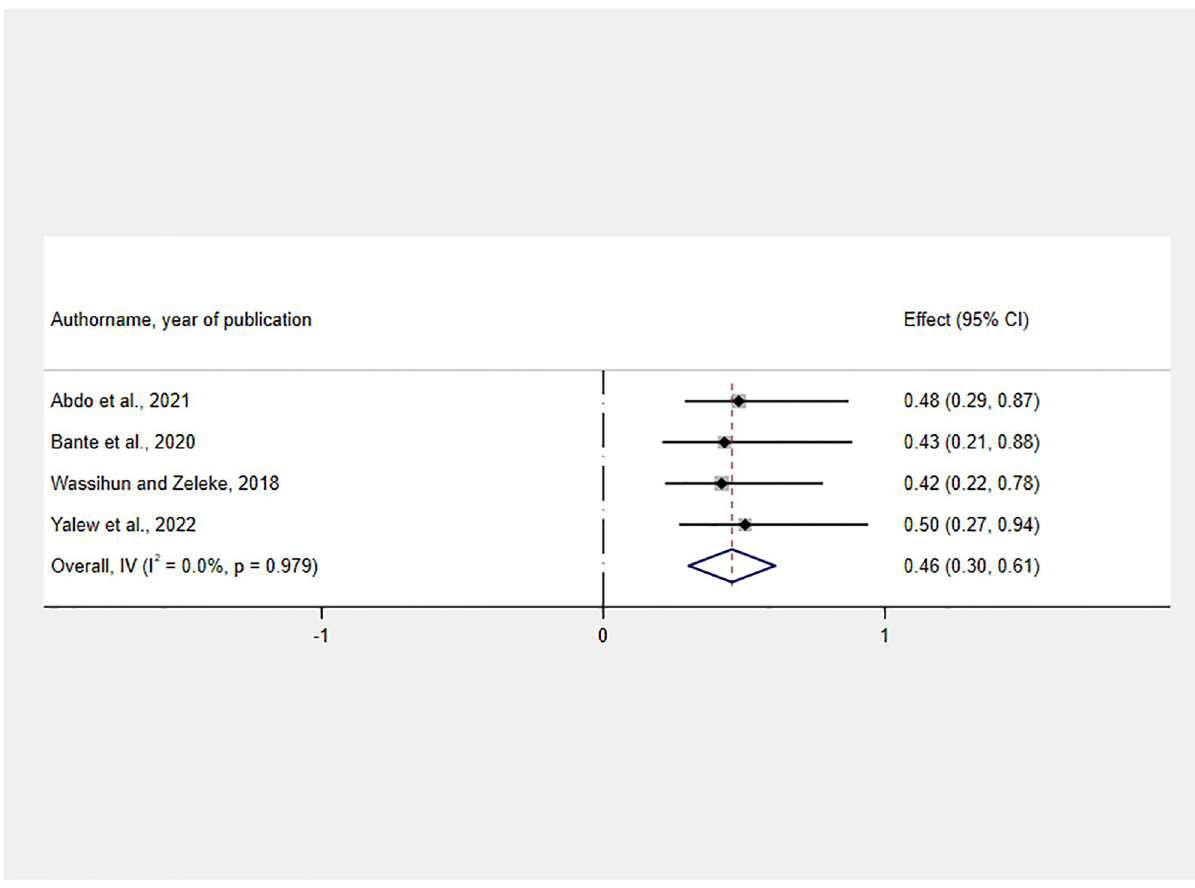
Fig 11. Forest plot showing the association between facing obstetric complications and RMC in Ethiopia, 2022.